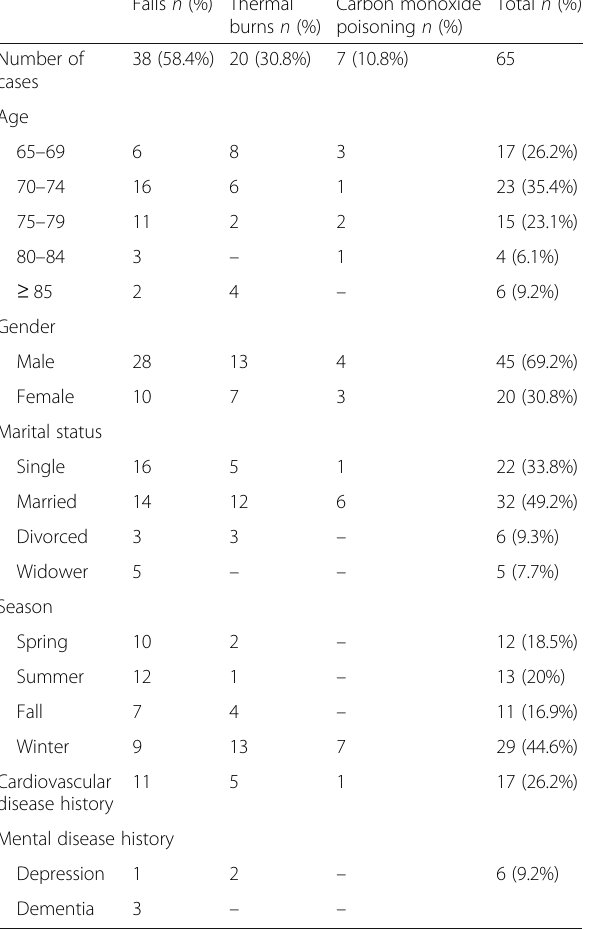
Table 5 Distribution of thermal burns characteristics and